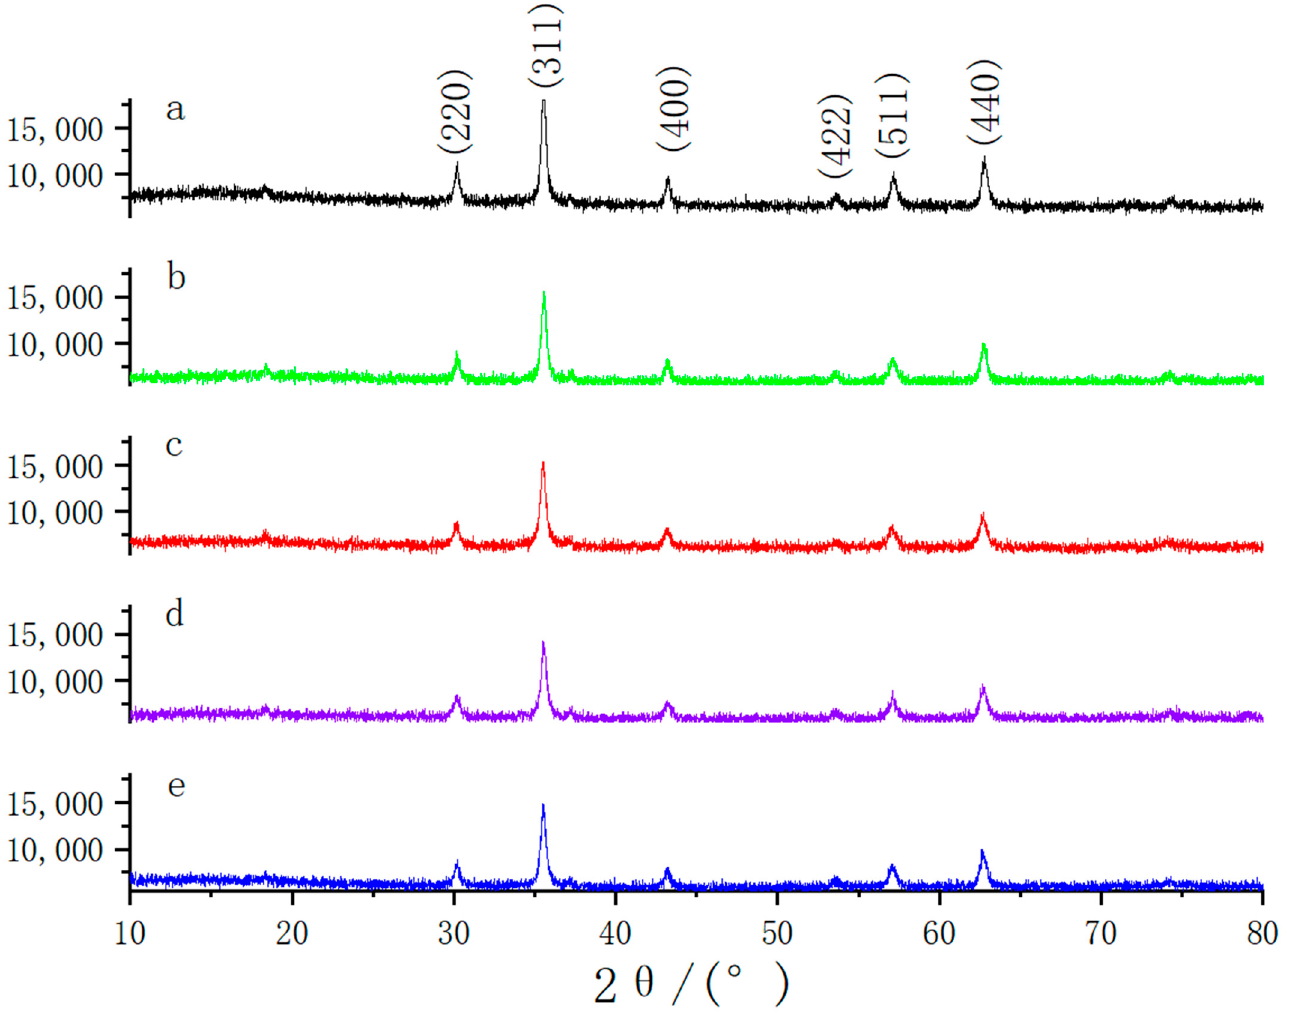
Figure 3. XRD image of Fe 3 O 4 . The amounts were: ( a ) 0.4 g NaOH; ( b ) 0.2 g NaOH; ( c ) 0.1 g NaOH; ( d ) 0.05 g NaOH; and ( e ) without using NaOH.